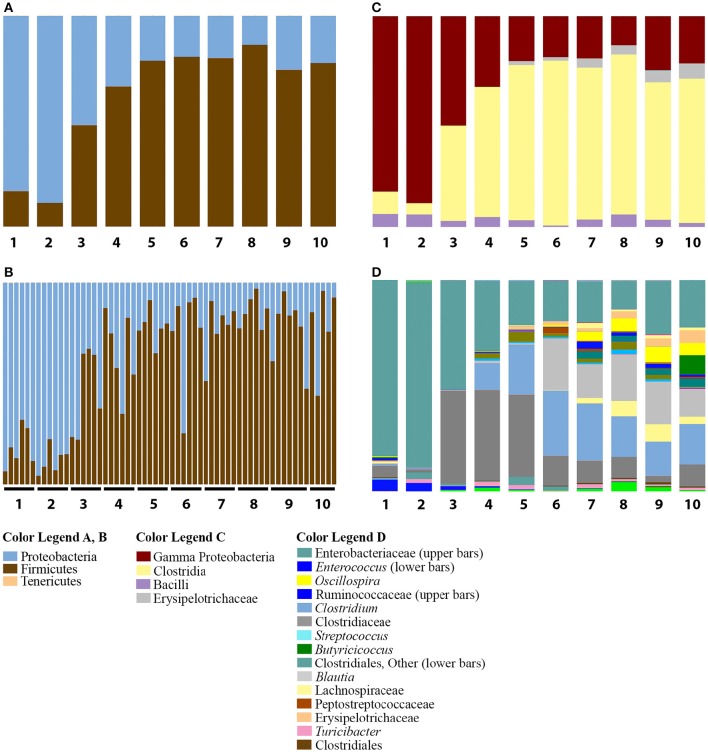
Summary of bacterial taxa observed by age of duck in Aviary Study 2. The relative abundances of bacterial 97% operational taxonomic units (OTUs) are shown for duck caecal samples from Aviary Study 2, representing the first 10 days of the grow out period. (A) Depicts phylum level classifications for observed OTUs for samples grouped according to age of the duck. Numbers under each bar indicate the age of the ducks in days. (B) Depicts phylum level classifications for observed OTUs of individual samples, sorted according to age of the duck. Each horizontal line underneath the bars encompasses the samples derived from ducks of the indicated age in days. (C) Depicts class level classifications for observed OTUs for samples grouped according to age of the duck. (D) Depicts genus level (or higher) classifications for observed OTUs for samples grouped according to the age of the duck. Full color legends for each panel are listed in Supplementary Table 5, Taxa Summary Legends. The observed transition from Proteobacteria to Firmicutes is seen to occur by Day 3 and occurs in all individuals that make up the age groups (A,B). The distribution of taxa below the phylum level shows that ages 4 and 5 are distinct from ages 6 to 10 (C,D).